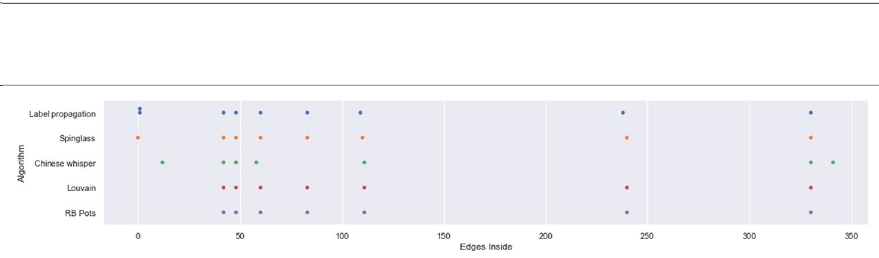
Fig. 8 Diseases ontology on vascular disease immune system disease, bone disease, pancreas disease, and lung cancer